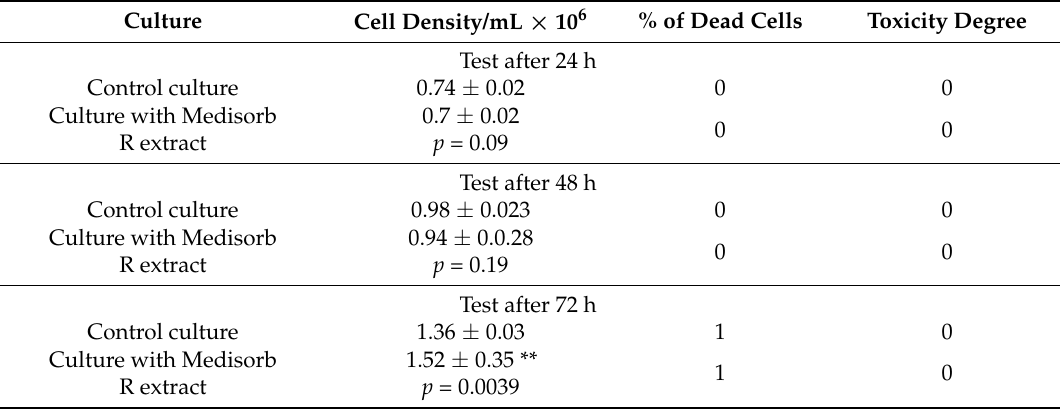
Table 8. Cytotoxicity test results of Medisorb R material in terms of 3T3/Balb mice fibroblasts. Culture Cell Density/mL × 10 6 % of Dead Cells Toxicity Degree Test after 24 h Control